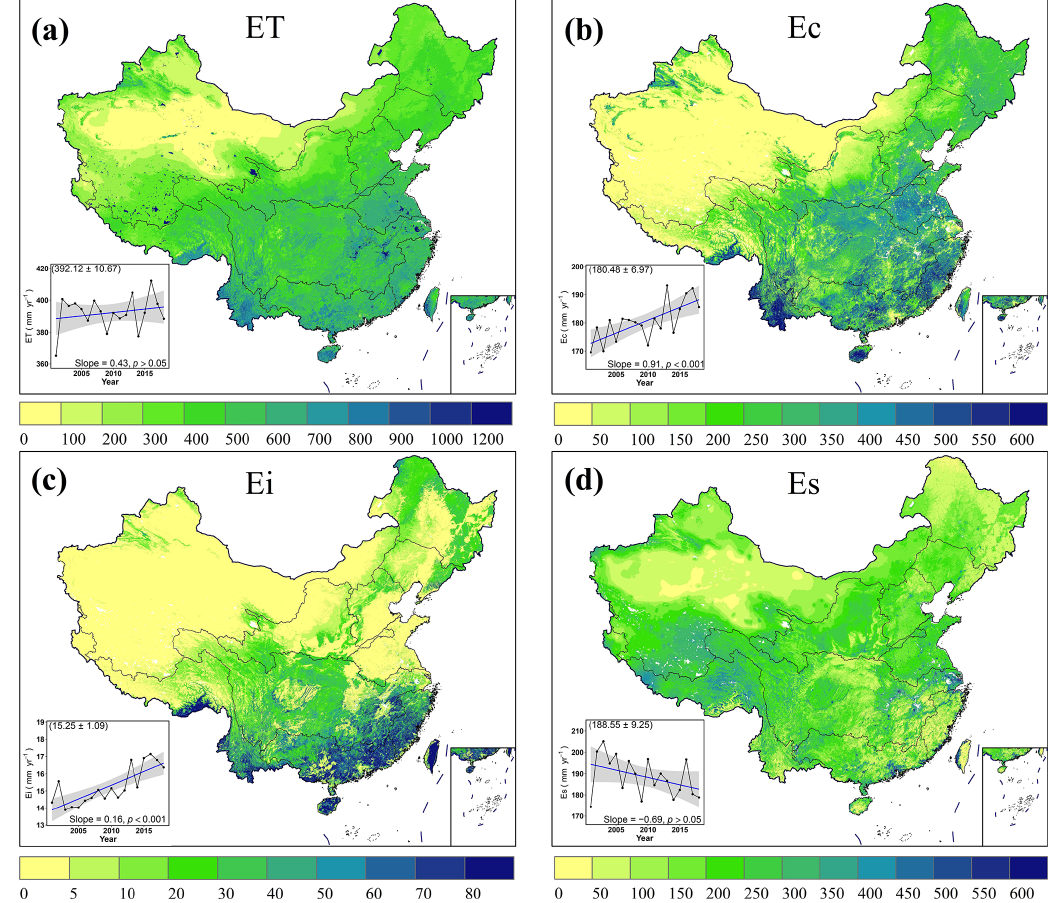
Figure 10. Spatial pattern of mean annual ET, E c , E i , E s , and their annual variation during 2001–2018. In all the insets, the shaded areas rep- resent the 95% confidence interval based on the linear regression modeling. The number in the parentheses of each inset is mean ± standard deviation of the annual simulated variables during the 18 years.